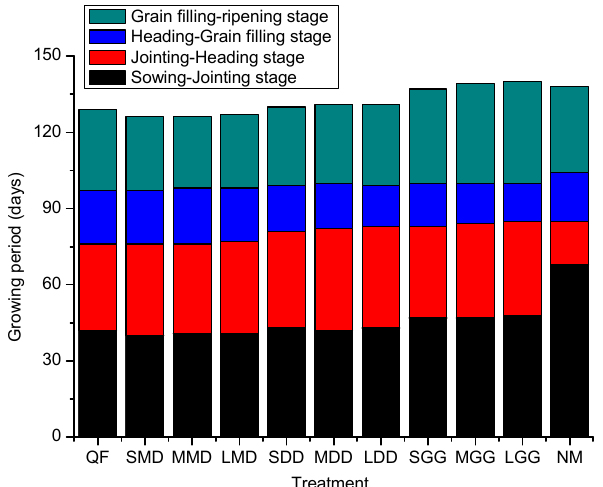
Figure 5. Growth period of maize in 2017. It was expressed as the bar chart and was comprised of sowing, jointing, heading, grain filling, and ripening stage.